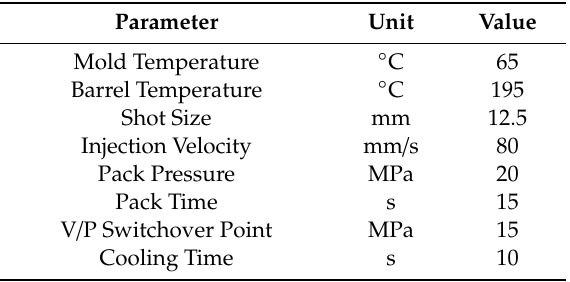
Table 5. Process molding conditions adopted for the experimental campaign.